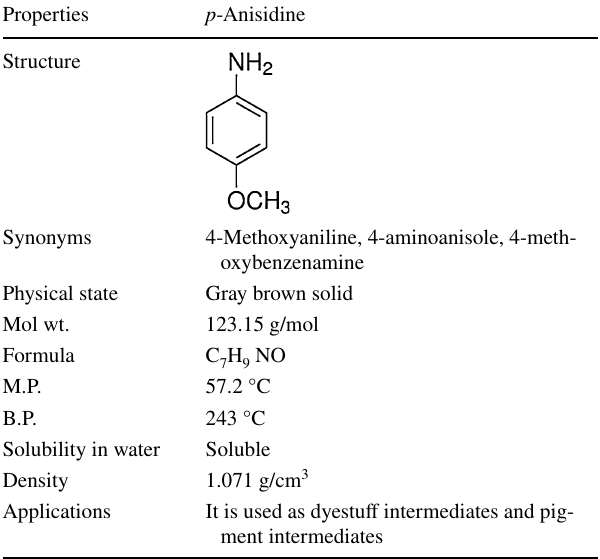
Table 1 Properties of p -anisidine. ( source : National Center for